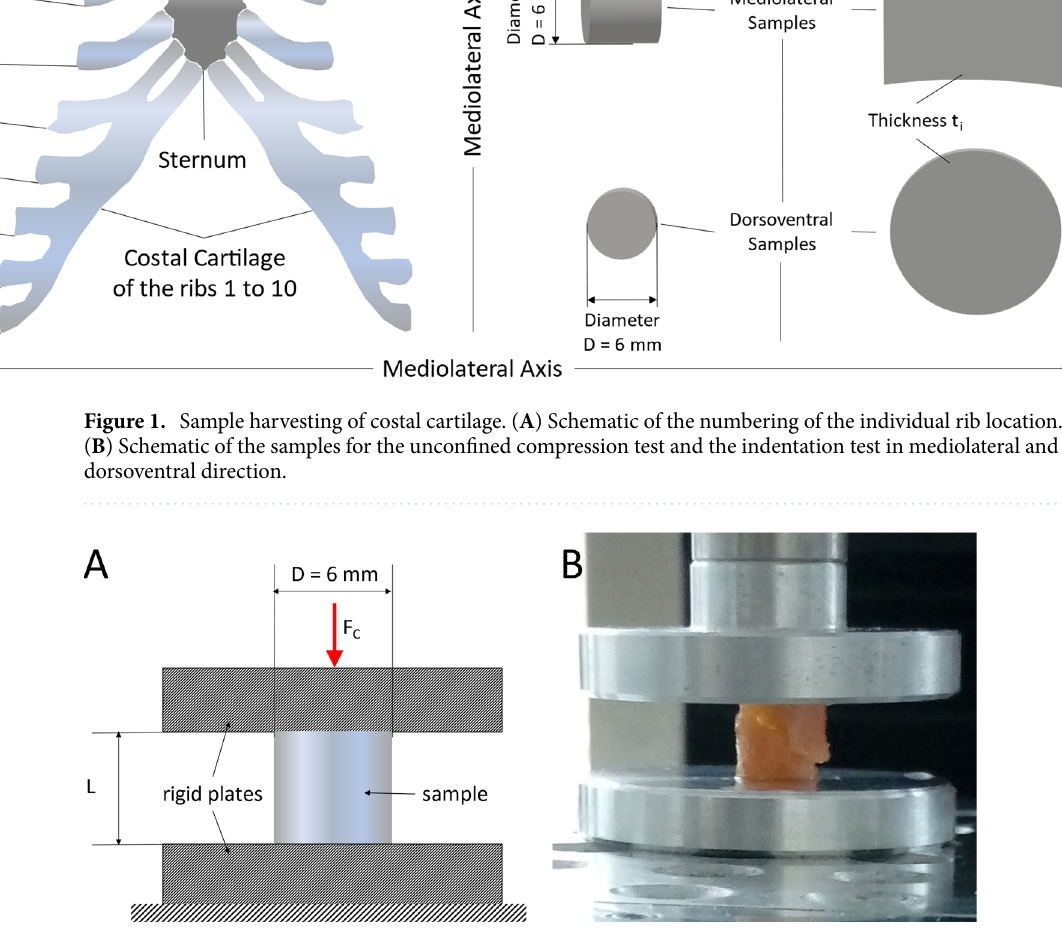
Figure 2. Experimental set-up of the unconfined compression test. The cylindrical samples were placed between two rigid plates (aluminum) with high stiffness. The friction between plates and specimen was reduced by lubricating the specimens and both plates with NaCl 0.9% before testing. ( A ) Schematic test set-up. ( B ) Photographic test set-up. The figure shows a sample after the test has been performed. The sample has a diagonal crack from the upper left corner to the lower